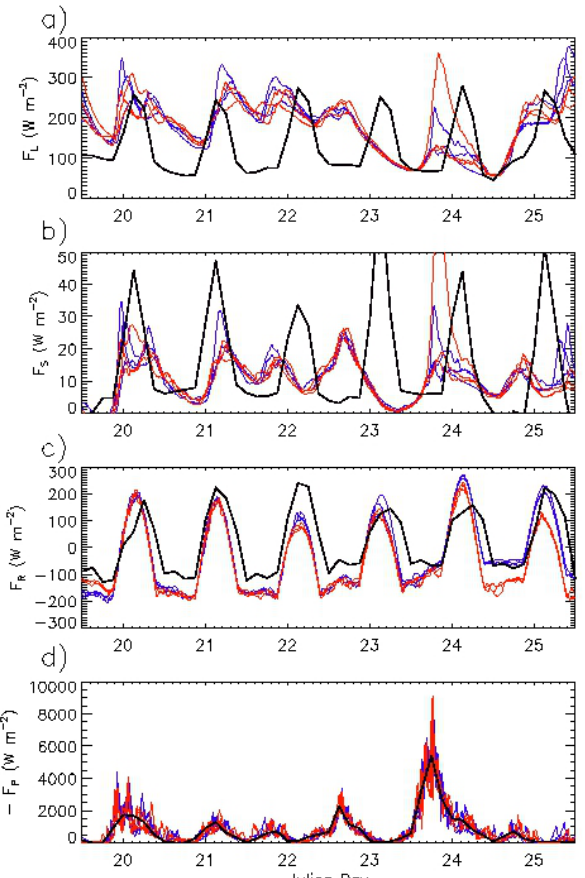
Fig. 5. As in Fig. 2, except timeseries of horizontally-averaged (a) surface latent heat flux, F L , (b) surface sensible heat flux, F S , (c) atmospheric radiative flux convergence, F R , and (d) surface precip- itation, F P . Observed values are indicated by black lines.